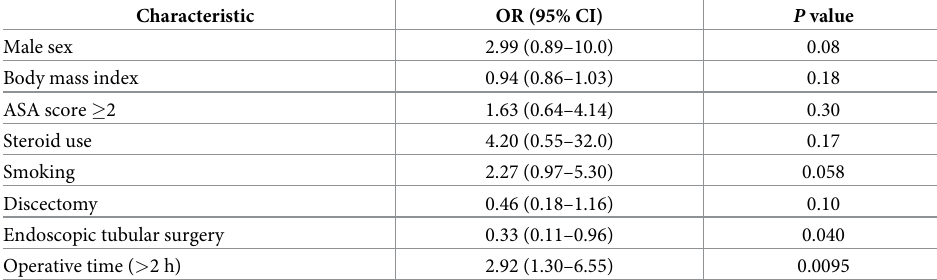
Table 3. Multivariable Logistic regression analysis with propensity score adjustment for SSI after lumbar lami- nectomy and/or herniotomy.